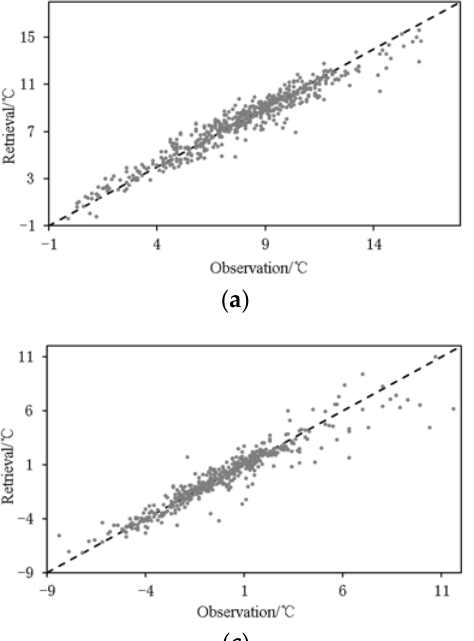
( d ) Figure 8. Scatter plot for observations and retrievals of road surface (bridge deck) temperature using stepwise regression model at road surface station 1 ( a ), road surface station 2 ( b ), bridge deck station